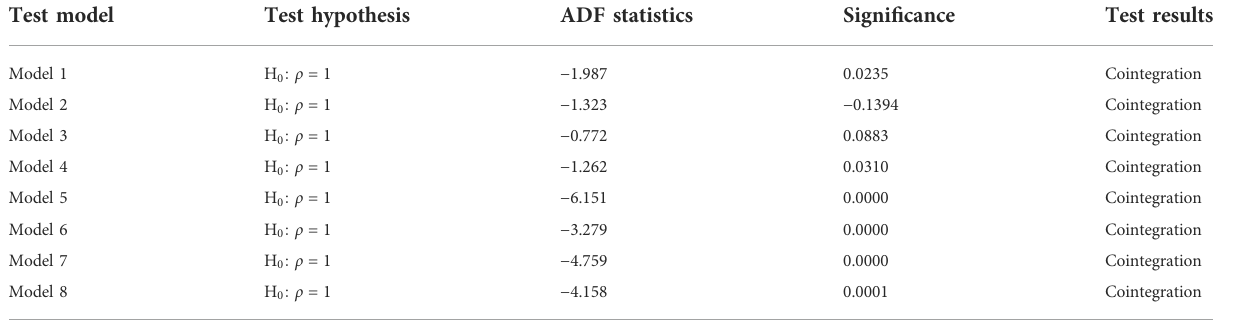
TABLE 5 Cointegration test for panel data.